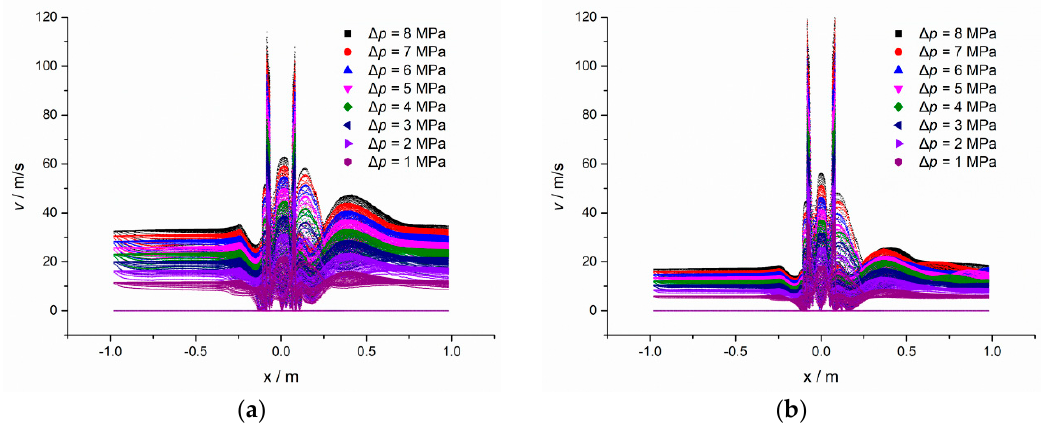
Figure 9. Velocity variation along the horizontal direction for different pressure differences ( a ) L = 60 mm; ( b ) L = 30 mm.